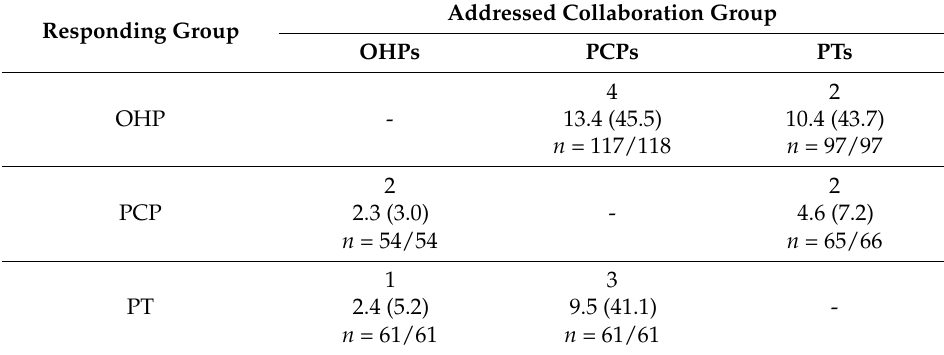
Table 2. Patients with a mental disorder, leading to contact with the respective other professional group within the last 24